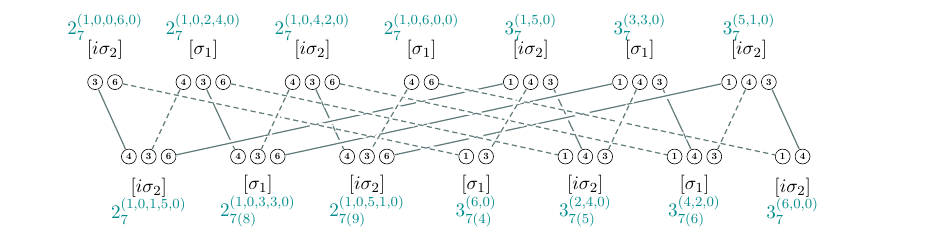
Figure 12 . T -duality chain of the E (7;7) -branes.